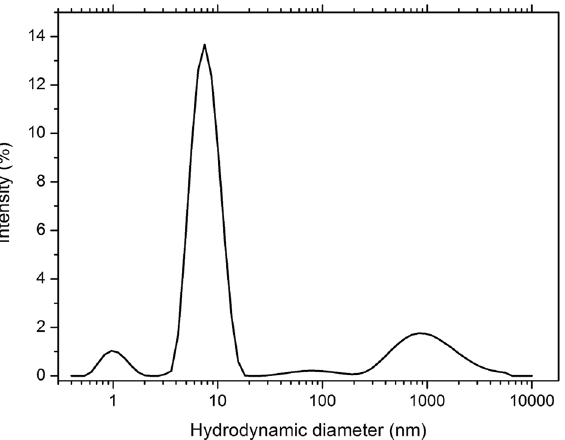
Figure 11. Intensity versus hydrodynamic diameter distribution curve measured for the stable, dark solution obtained by full reaction of HGA. The curve is the average of three different measurements. A prevalent contribution from species with a hydrodynamic diameter around 8 nm is